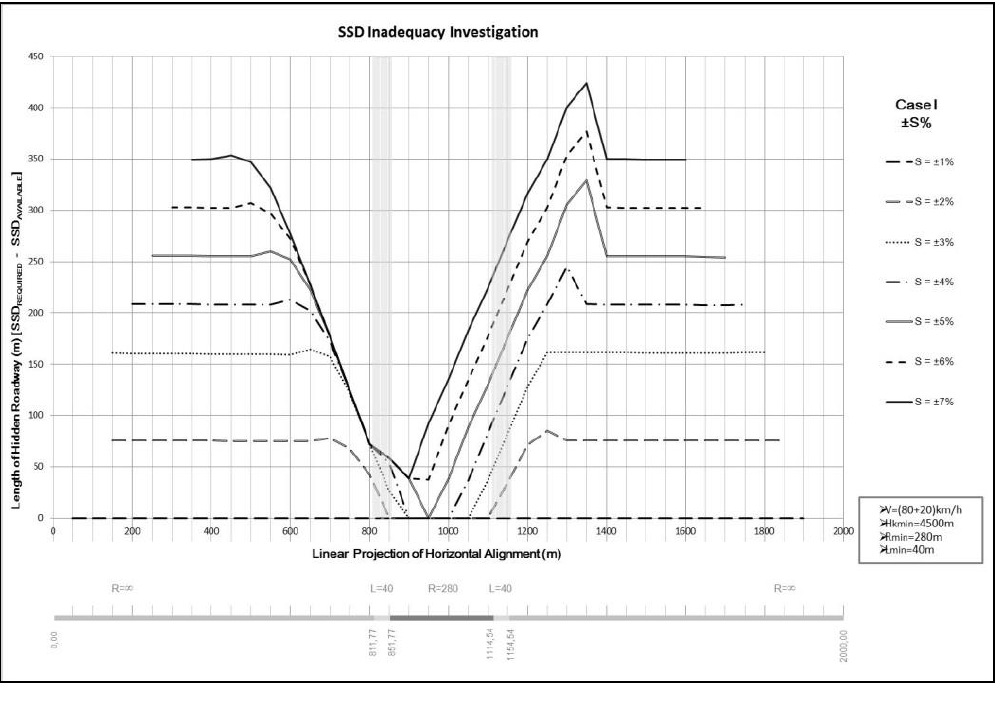
Figure 3: SSD adequacy investigation (Case I)